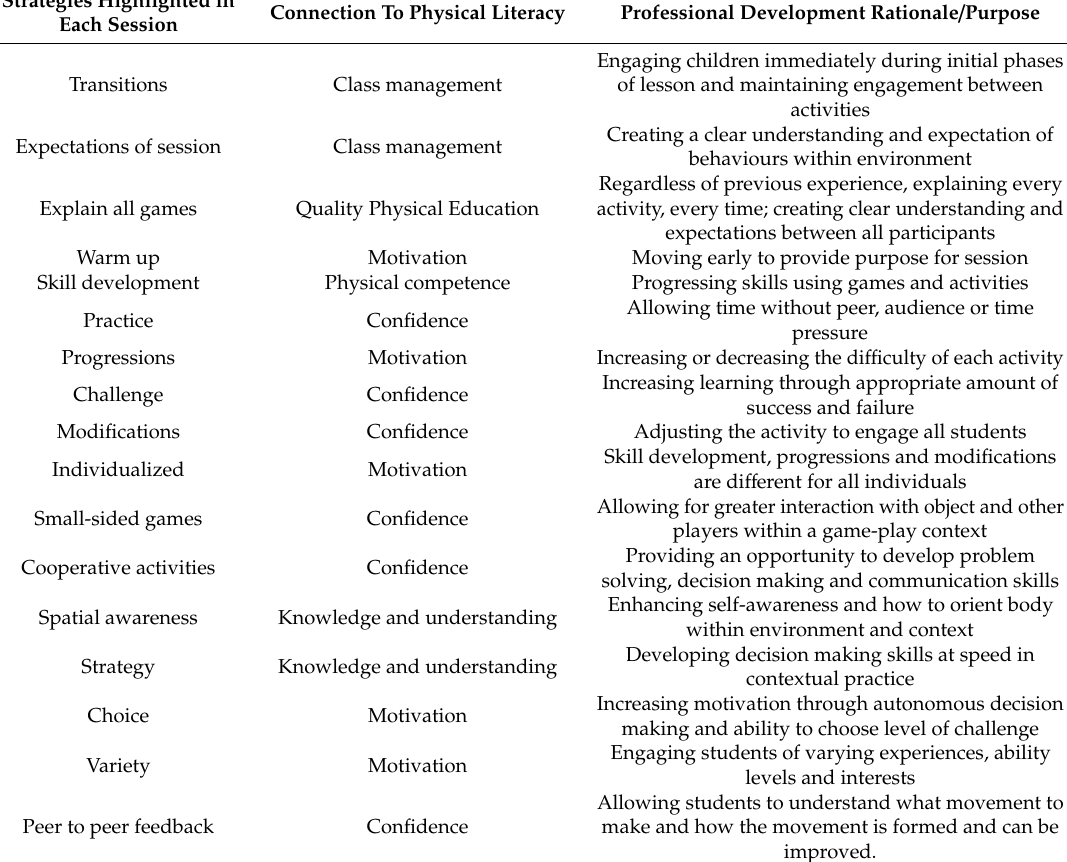
Table 1. Strategies implemented in each session, their connection to physical literacy and the rationale provided to teachers for their use within a physical education setting.